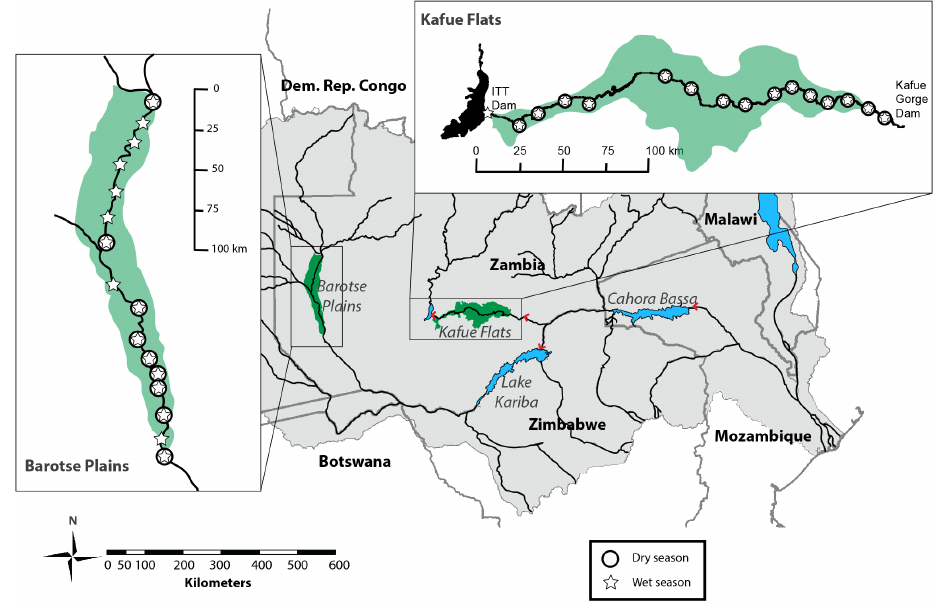
Figure 1. Map of the Zambezi catchment, with floodplains (in green) and large dams (red arrows) marked. Inserts show sampling stations during the dry (circles) and wet season (stars) in the Barotse Plains and Kafue Flats. Sampling stations will be further presented in distance along the river